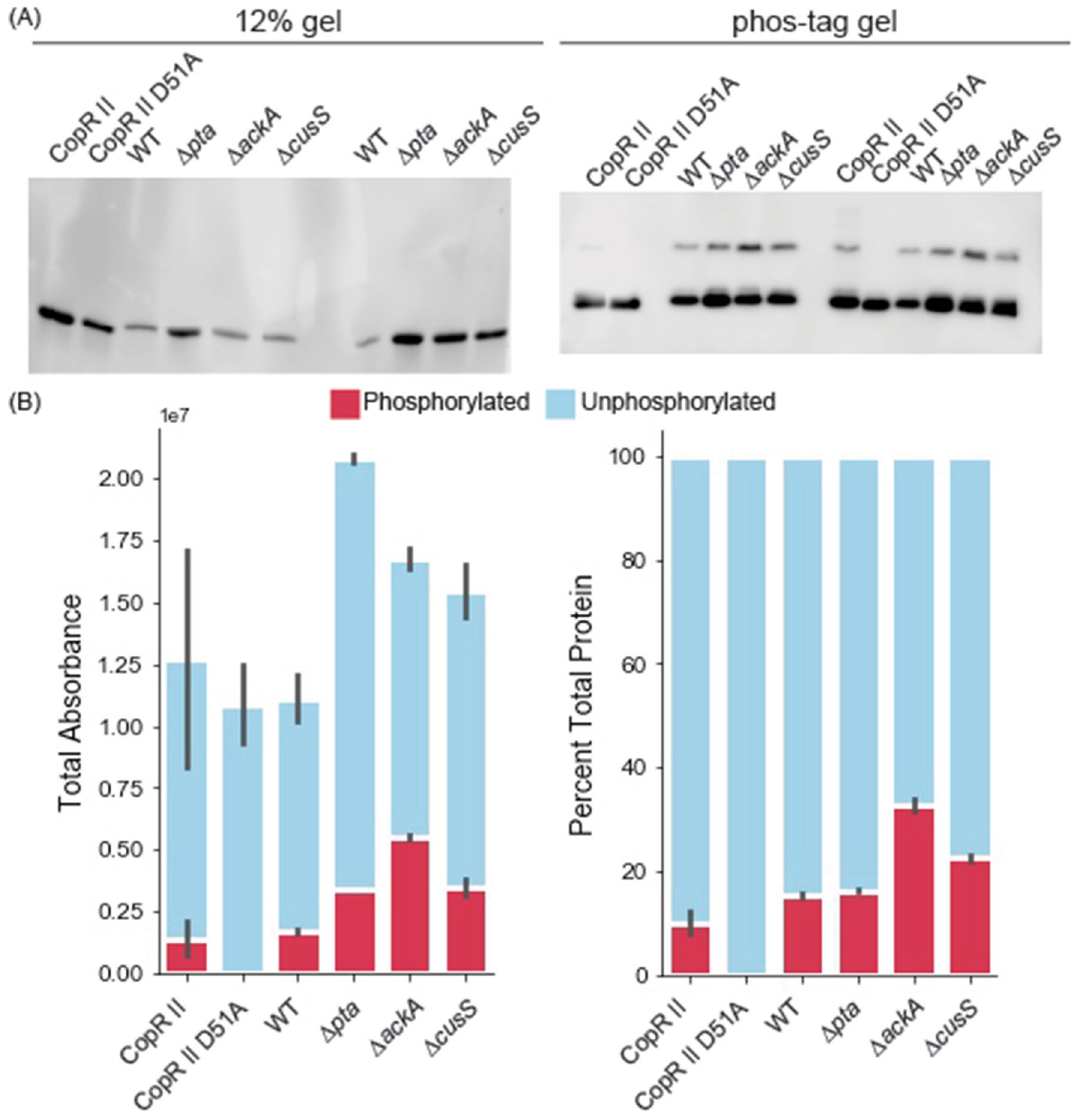
Figure 4. Cultivation in deletion strain influences the phosphorylated population of recombinant CopR II ( A ) 12% and phos-tag western blots and ( B ) quantitation by total and percent absorbance for CopR II cultivated in temperatures for greater than 6 months before electrophoretic separation. Bars and error bars represent the averages and standard errors between the average of two technical